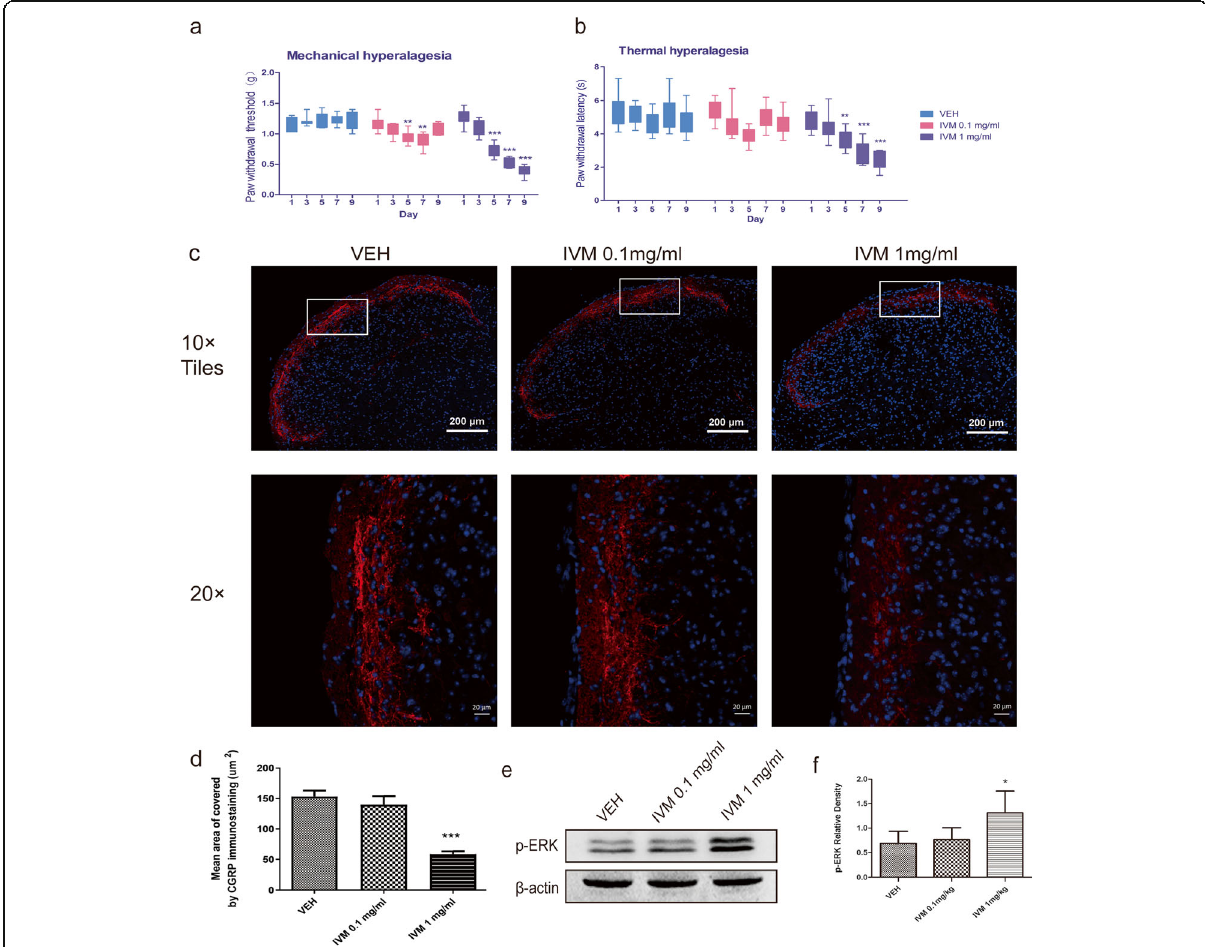
Fig. 4 The effect of repeated IVM administration on migraine-related behaviours and neurochemical signalling in the TNC. Mice were treated with IVM every second day for 9 days with two doses (0.1 mg/ml or 1 mg/ml, i.p.). a , b Mechanical and thermal hyperalgesia were assessed in different groups. p < 0.01 for drug, time, and interaction. Two-way RM ANOVA and Bonferroni post hoc analysis. n = 9/group. ** p < 0.01, *** p < 0.001 versus VEH group. c Representative photos of CGRP-immunoreactive staining in the TNC of different groups under a 10 × objective lens (upper row, scale bar = 200 μ m) and 20 × objective lens (lower row, scale bar = 20 μ m). The white box was enlarged. d Mean area covered by CGRP-immunoreactive fibres in different groups. One-way ANOVA. n = 8/group, *** p < 0.001 versus VEH. e , f Representative Western blot results for p-ERK in different groups. One-way ANOVA and Tukey ’ s multiple comparison test. n = 6/group, * p < 0.05 versus